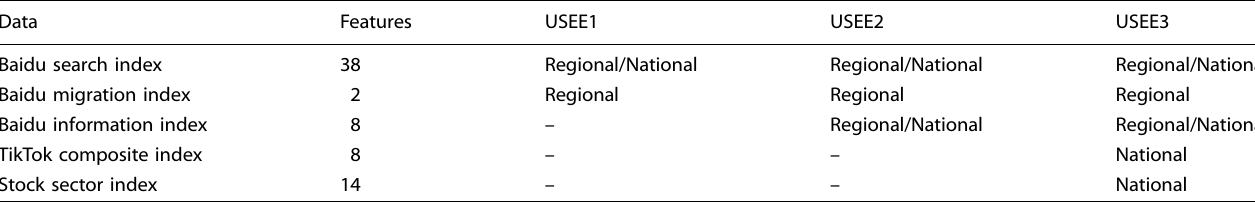
Table 1. Data selection of the classi fi cation models.